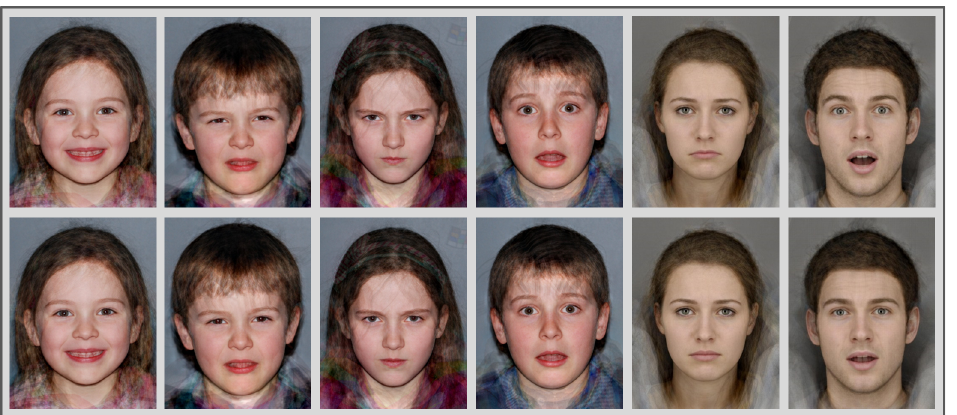
Fig 1. Examples of the 6 face prototypes each showing one of the 6 emotional expressions at each intensity. From left to right: age 5 – 8 female happy, age 5 – 8 male disgusted, age 9 – 12 female angry, age 9 – 12 male afraid, adult female sad, adult male surprised. The top row contains the the more intense versions and the bottom row contains the less intense versions. It is not possible to identify any individual's face from the final prototypes, therefore we did not require permission to publish these images.